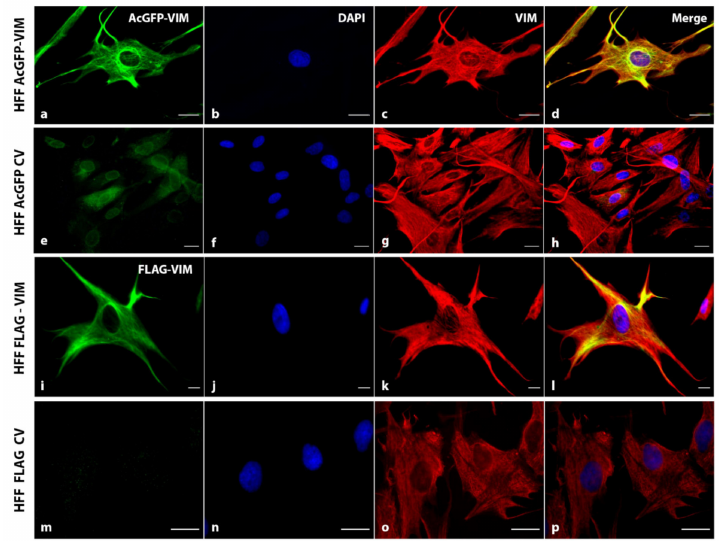
Figure 5. Integration of N-terminally tagged vimentin into the pre-existing vimentin filaments . HFF-1 cells expressing AcGFP-VIM, control vector (CV) AcGFP, FLAG-VIM and control vector (CV) FLAG were immunostained with anti-VIM antibody (for endogenous vimentin network) and AF-594- labelled goat anti-mouse as secondary antibody (red). For cells expressing 3 × FLAG constructs, cells were stained with anti-FLAG antibody and AF-488 labelled goat anti-rabbit as secondary antibody (green). Nuclei were stained with DAPI in blue and all overlapping images are shown as ‘Merge’. Leica DM4000B Epi-fluorescence microscope was used for visualisation and DFC350 camera was used for image recording (scale bar = 20 µ m). Note that N-terminally tagged vimentin (green colour panels ( a , i )) has integrated into the endogenous vimentin (red colour panel ( c , k )) filament network in HFF-1 cells which becomes yellow ( d , l ) in ‘Merge’. No disruption of pre-existing vimentin